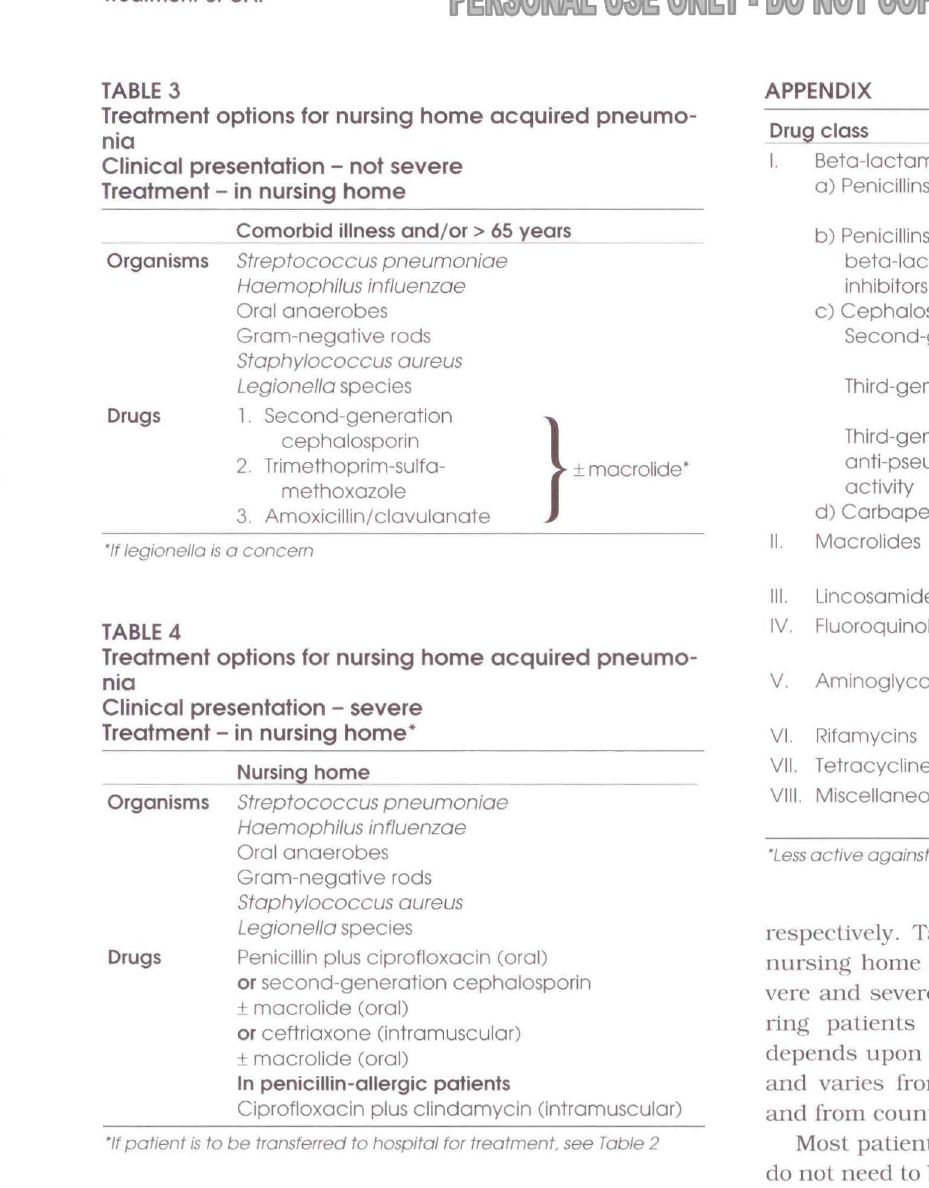
Treatment options for nursing home acquired pneumo nia Clinical presentation - not severe Treatment - in nursing home